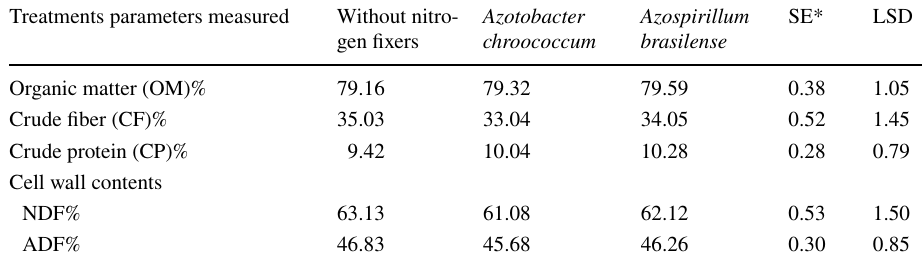
Table 4 Effect of nitrogen fixers on the nutritional quality of rice straw